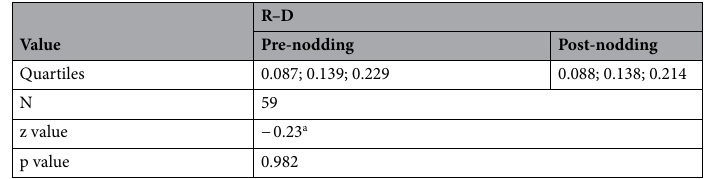
Table 2. Comparison of the temporal parameters obtained before and after the head-nodding period (Wilcoxon rank-sum test). a Based on positive rank. Temporal values were given in milliseconds. The outliers were removed on the base of Box and Whisker Plots analysis.